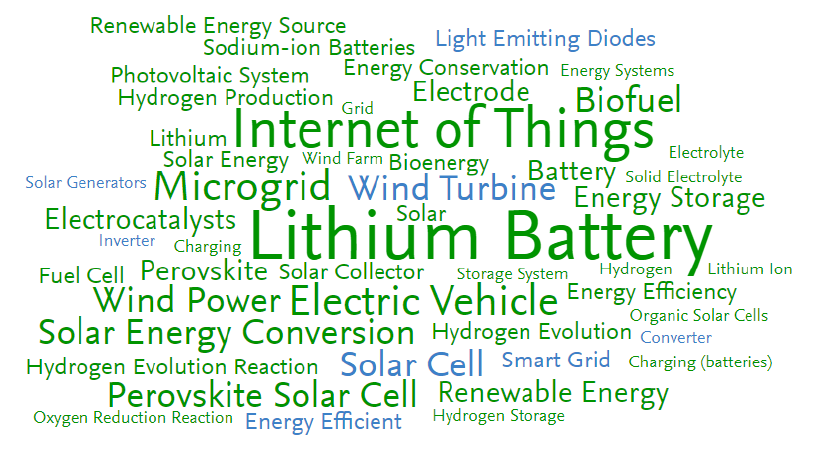
Figure 2. Key phrases analysis results for SDG 7 research area in